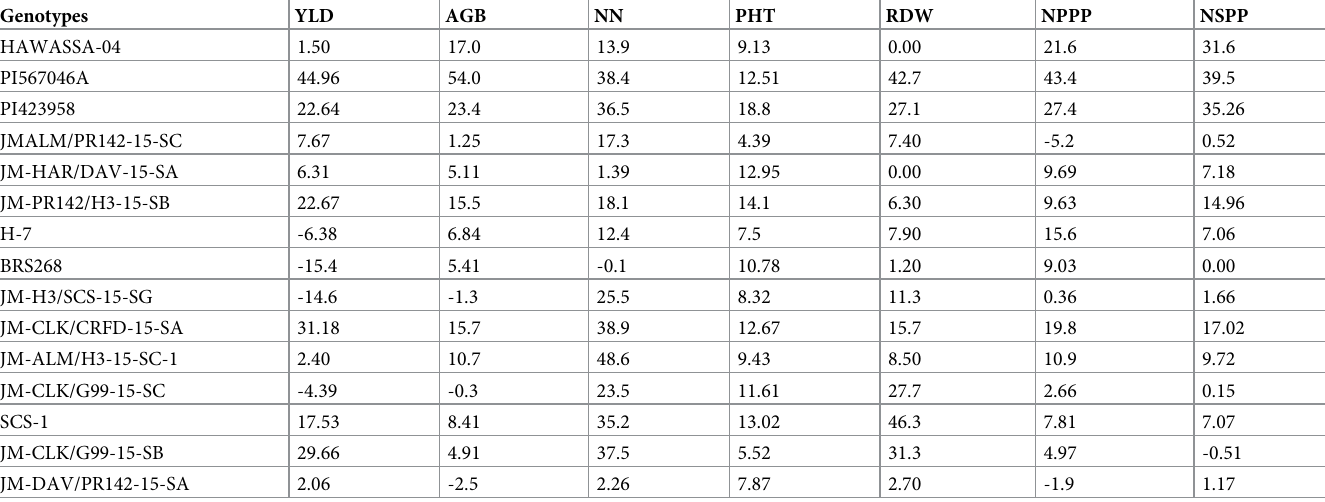
Where, NPPP = number pod per plant, NSPP = number of seeds per plant, PHT = plant height, RDW = root dry weight, YLD = yield, NN = number of nodules per plant, AGB = above ground biomass